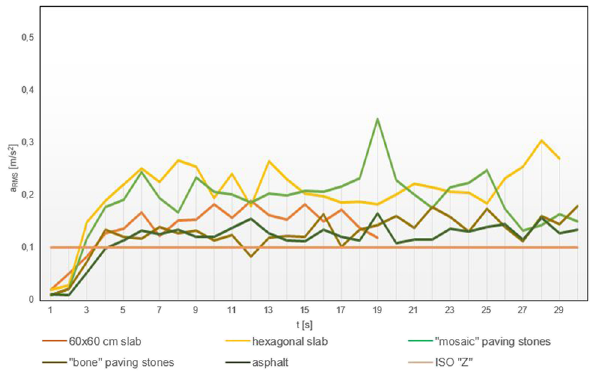
Figure 6: Variation in time of the amplitude vibration acceleration a RMS ( m/s 2 ) ( with the ISO comfort limit marked ) during the passage of a disabled person in an active wheelchair on di ff erent surfaces – fi ltration with a 1/3 octave fi lter 8 Hz, direction “ Z . ”